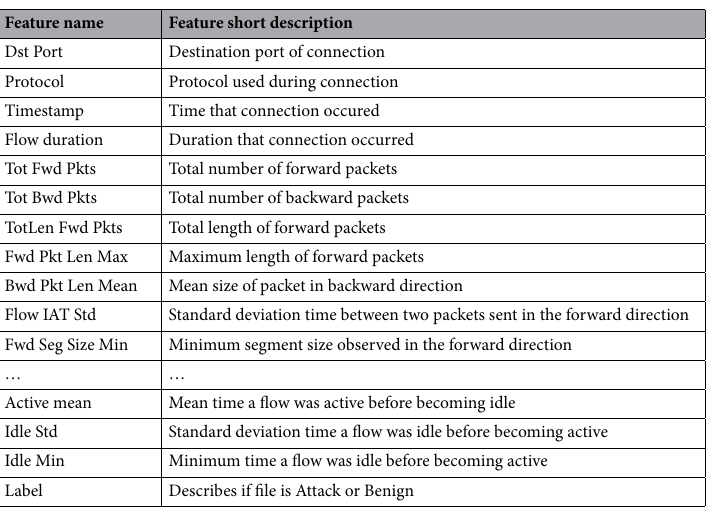
Table 2. A part of features in the dataset. The first column is the name of the feature. The second column is the description corresponding to the